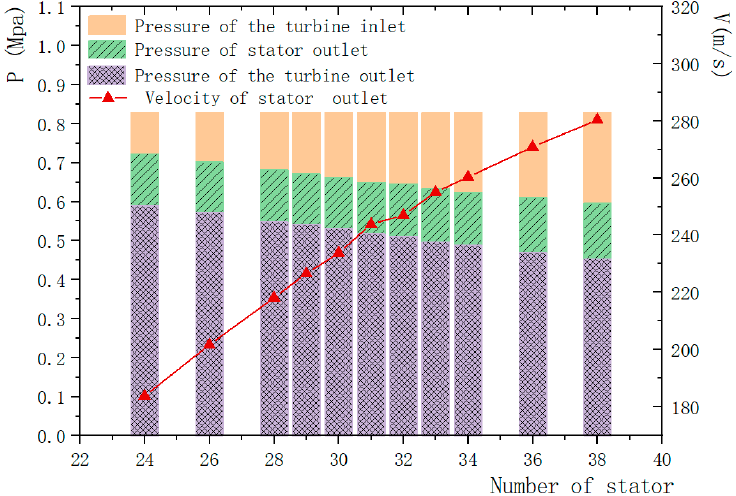
Figure 9. The influence of the number of stator blades on the pressure of the turbine inlet and outlet, the pressure of stator outlet and the velocity of stator outlet.